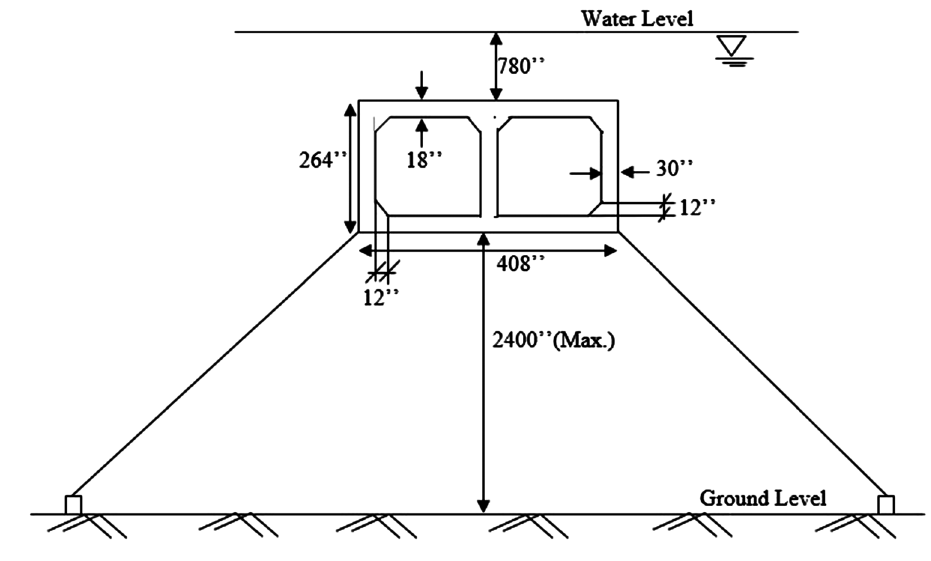
Fig. 1 Cross-section of SFT